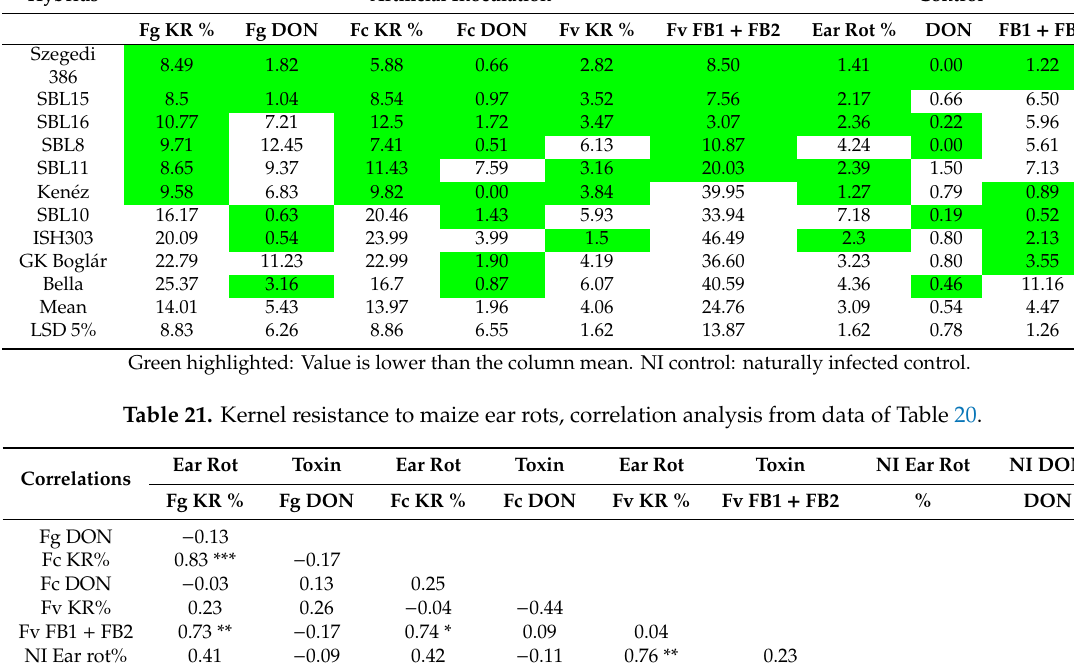
Table 20. Kernel resistance of maize to toxigenic Fusarium ear rots and natural contamination as well as their toxin contamination, 2010–2012. Hybrids